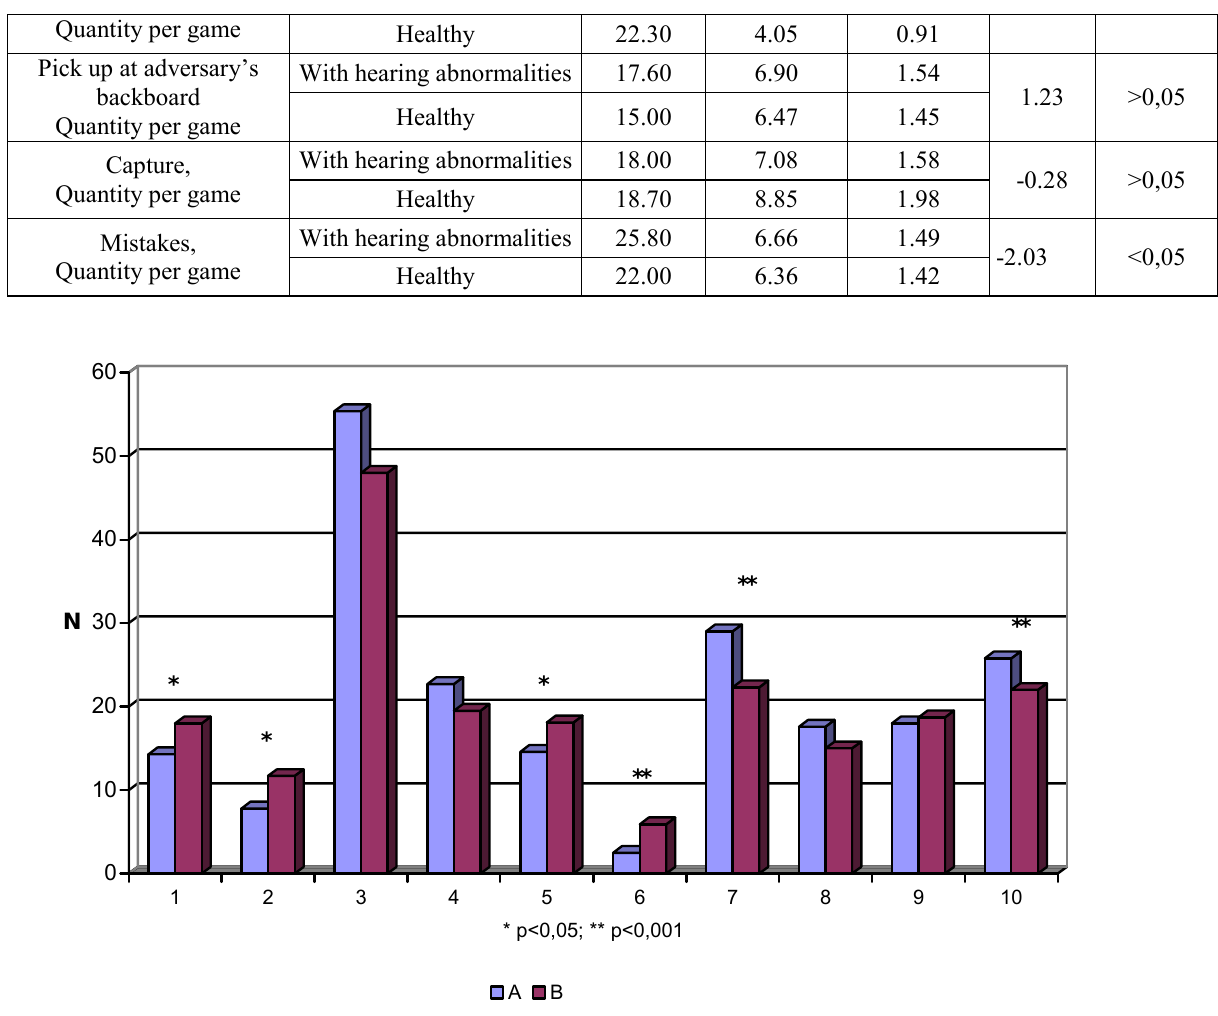
Fig. 1/ Indicators of competition activity of qualified sportswomen with hearing abnormalities (A, n=20) and qualified healthy sportswomen (B, n=20) 1 - Penalty throws; 2 – Penalty hits; 3. - 2 scores throws; 4 - 2 scores hits; 5 - 3scores throws; 6 - 3 scores